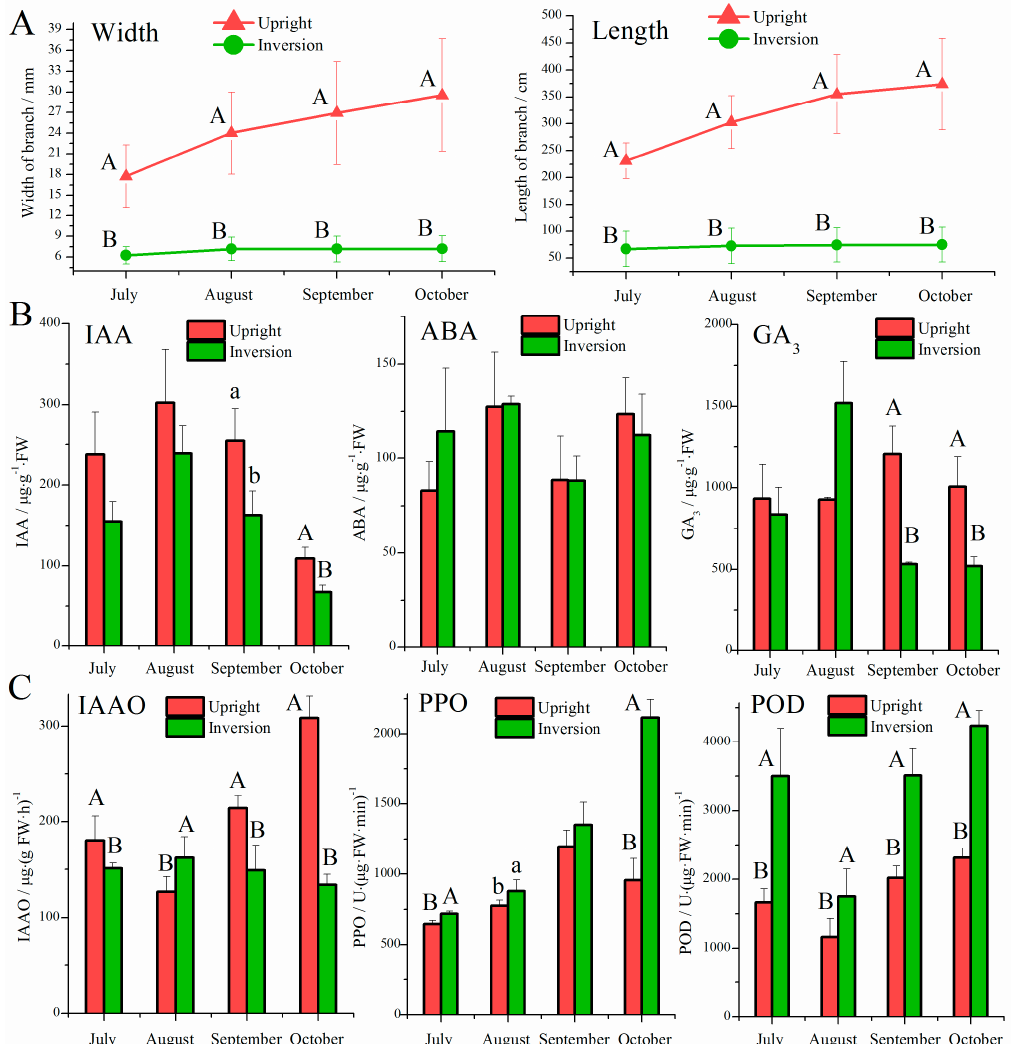
Figure 1. Comparison of vegetal and physiological characteristics between upright and inverted cuttings. ( A ) Width and length of branches. ( B ) Contents of indole-3-acetic acid (IAA), abscisic acid (ABA) and gibberellic acid (GA 3 ) in the top leaves. ( C ) Activities of IAA oxidase (IAAO), polyphenol oxidase (PPO) and peroxidases (POD) in the top leaves. Data are given as the mean ± standard error (SE). Different lowercase letters and capital letters indicate significant differences between upright and inverted cuttings at the 0.05 and 0.01 levels,